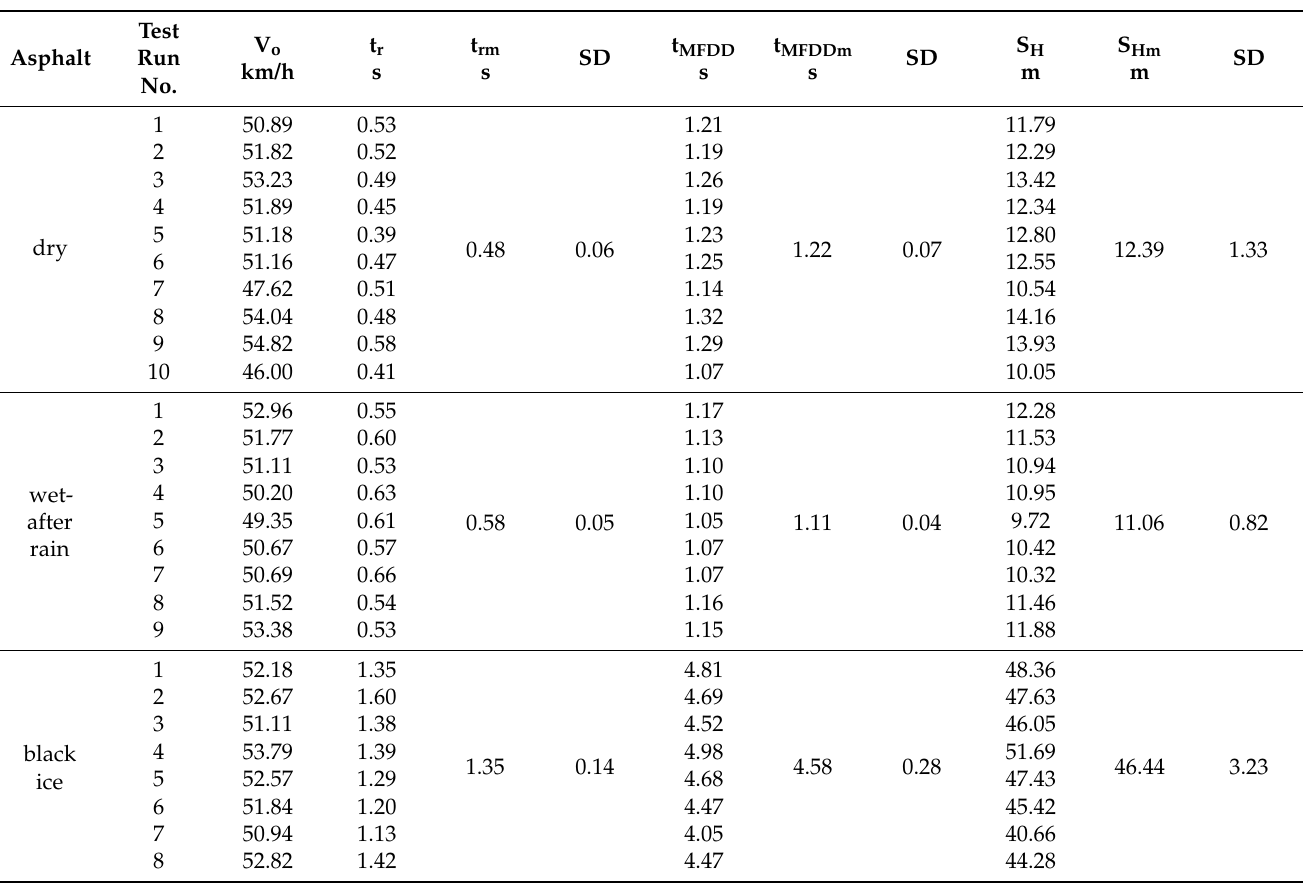
Table 6. The Ford Transit’s deceleration times and braking distances during rapid braking on a dry surface, a wet (after rain) asphalt surface, and a surface covered with a thin ice layer with the initial speed of approximately 50 km/h.